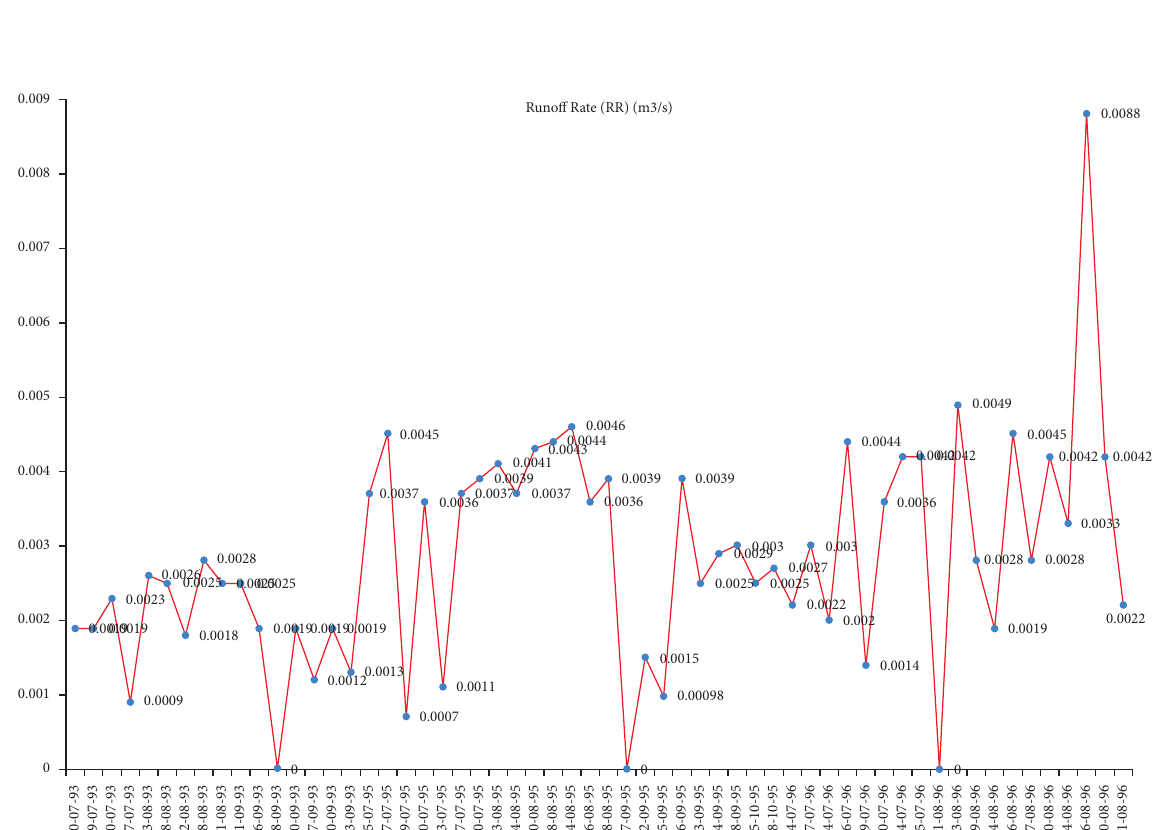
Figure 9: Observed runoff with the selected dates of observation.